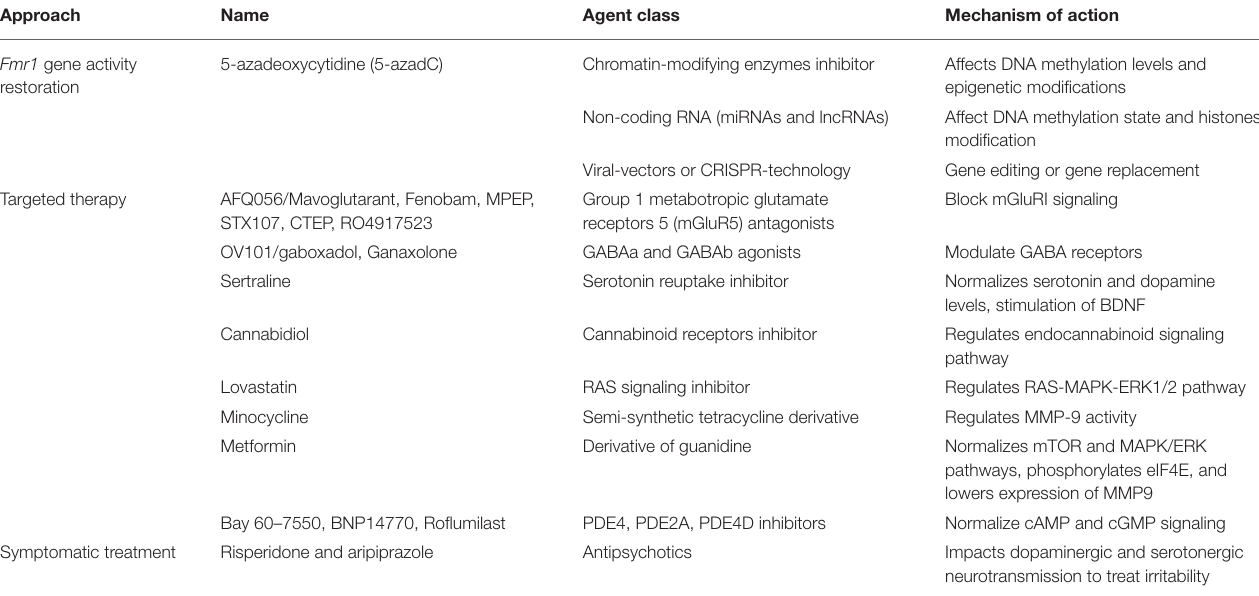
TABLE 1 | Treatments for Fragile X